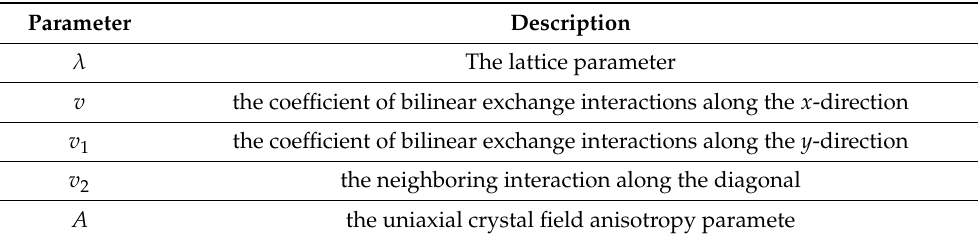
Table 1. The descriptions of the